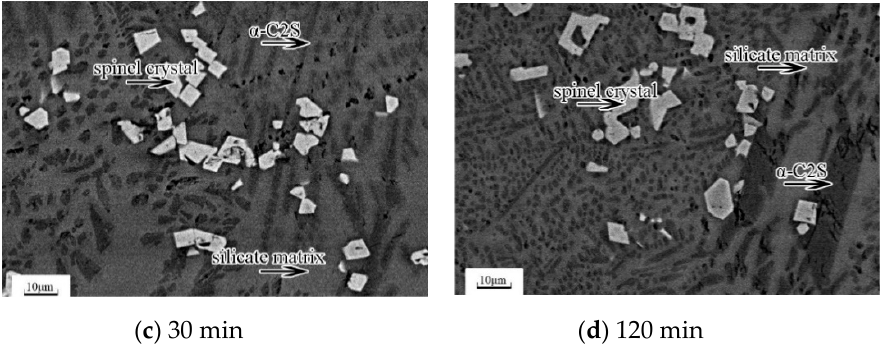
Figure 3. Effect of heating time on the microstructure of the slag samples at 1450 °C.